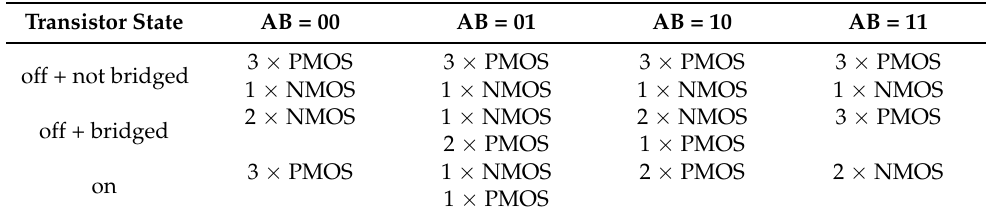
Table 1. Transistor states in a BSPL NAND gate for different